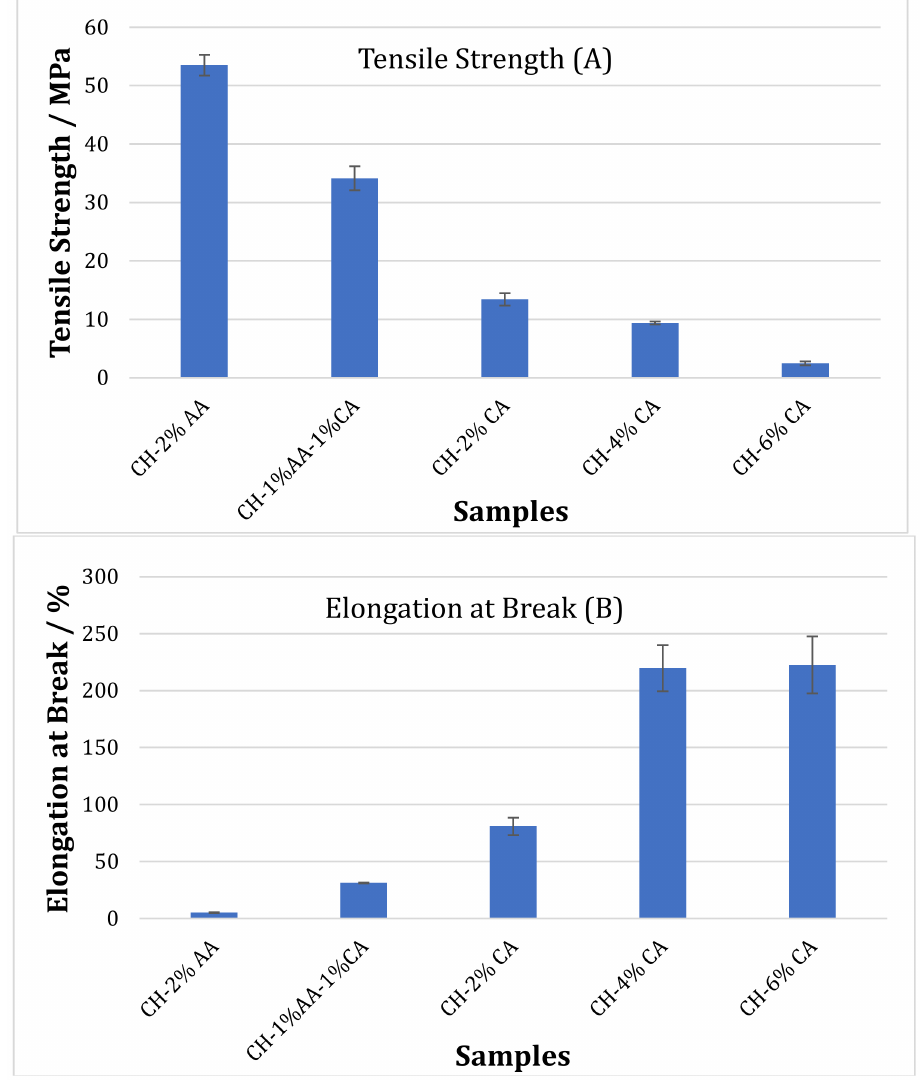
Figure 2. Tensile Strength ( A ) and Tensile Modulus ( B ) of the chitosan films prepared using acetic acid (2% v / v ) and citric acid (2, 4 and 6% w / v